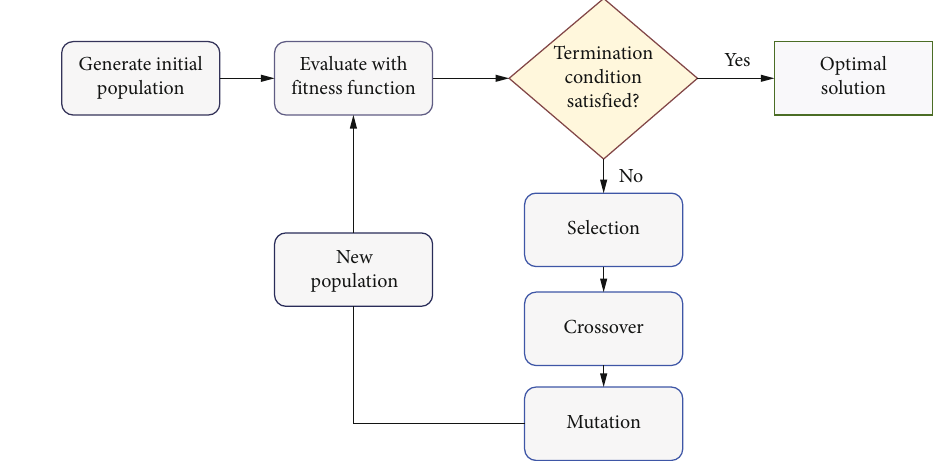
Figure 3: Generic genetics algorithm.